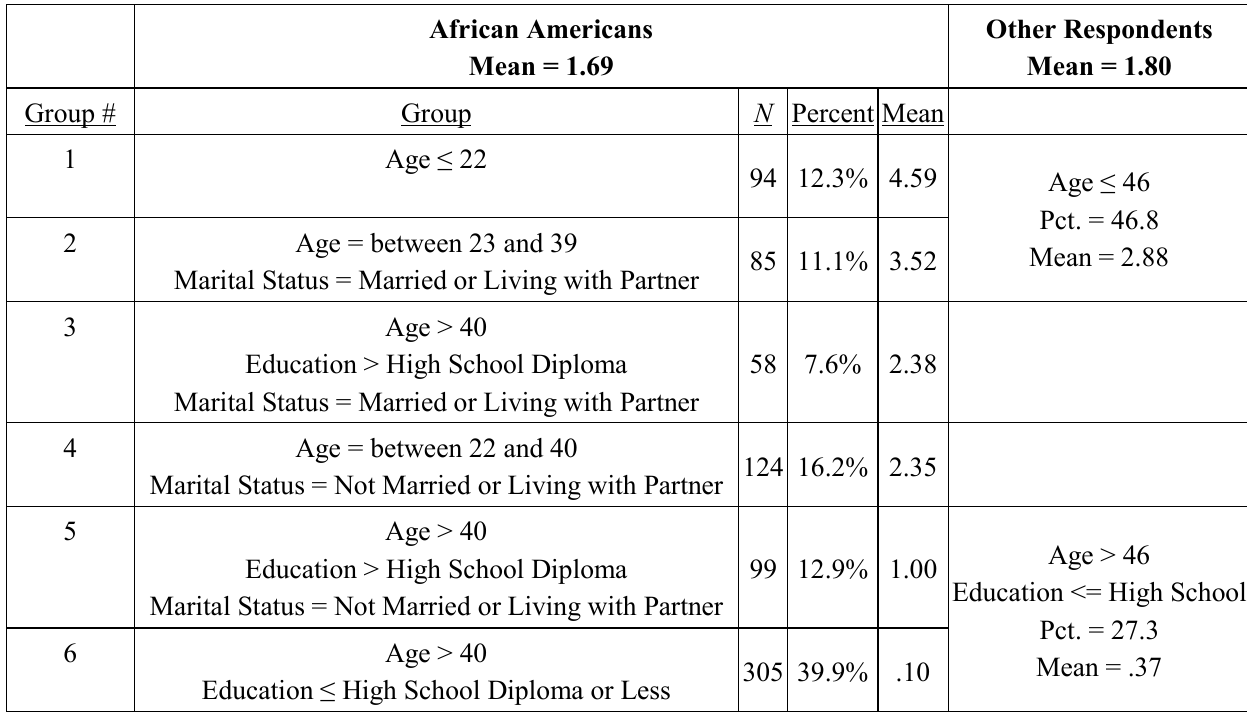
Table 5. CART analysis for advanced